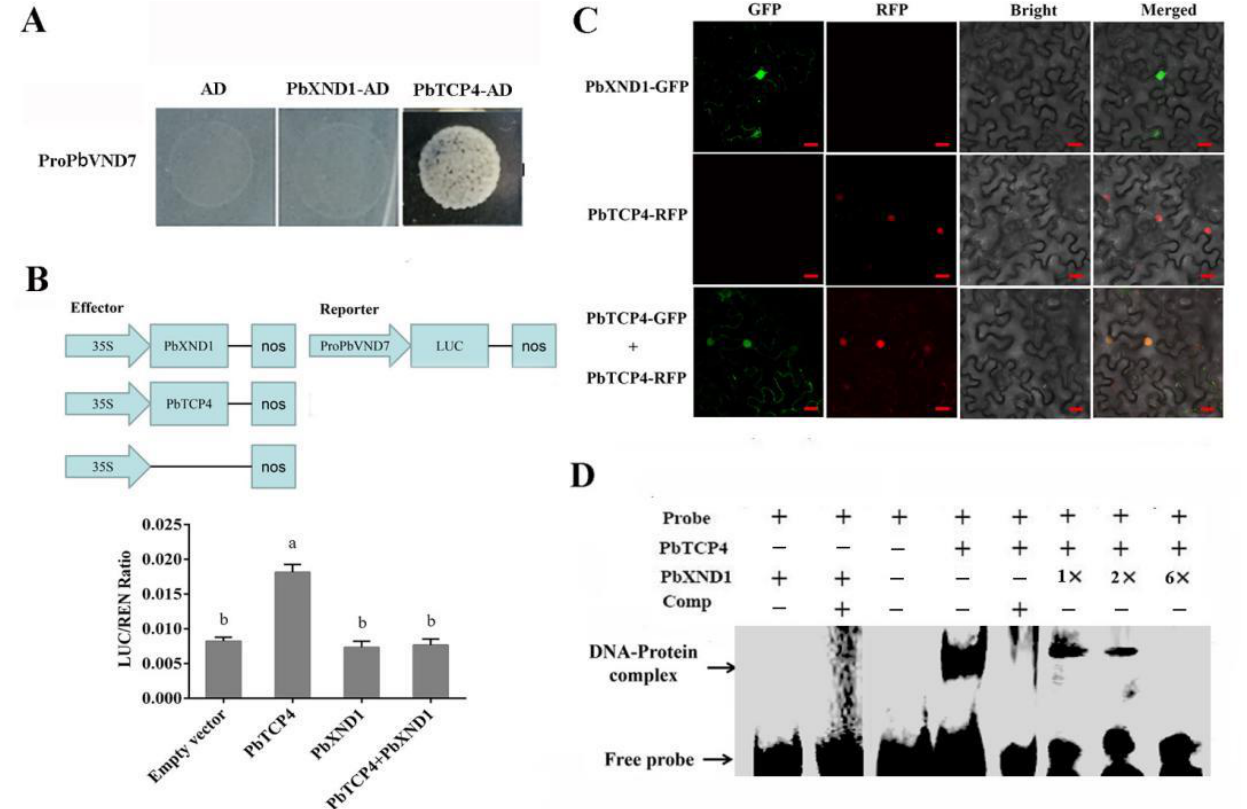
Figure 5. PbXND1 can repress the transcriptional activity of PbTCP4. ( A ) Interaction of PbTCP4 with the promoters of PbVND7. ( B ) Vector structure of the effector and reporter used for the tobacco transient expression assays. PbXND1 can repress the transcriptional activity of PbTCP4, as verified by the luciferase assay. Data are shown as means ± SD ( n = 3). Different letters denote statistical significance ( p < 0.05). ( C ) Subcellular localization and co-localization of PbTCP4 and PbXND1. Bars, 50 µm. ( D ) PbXND1 affected the DNA-binding ability of PbTCP4 according to EMSA analysis.